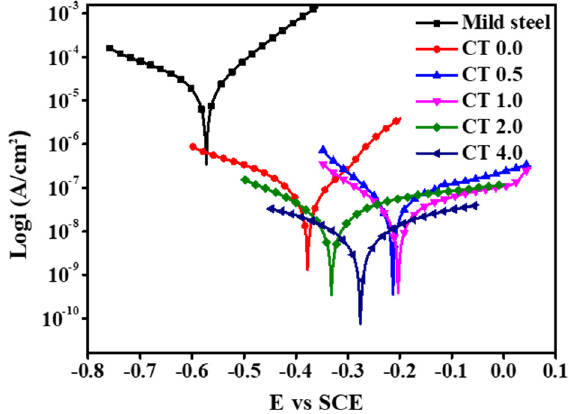
12 Figure 11. WCA of NIPU Composite Films . 3.3.7. Polarization Studies Tafel polarization measurement is a technique for analyzing the anti-corrosive prop- erties of polymeric coatings by evaluating the current vs. potential. By this technique, cor- rosion current (I corr ), corrosion potential (E corr ) and corrosion rate (C R ) on the metal panels were measured [36–38]. I corr and E corr will give bisecting extrapolated lines from both the oxidation and reduction parts. The Tafel study (Figure 12 and Table 5) of NIPU coated on the mild steel panel (3 × 3 cm 2 ) demonstrated that as loading of TANI increased, the rate of corrosion decreased. E Corr values of the coated NIPU panel shifted more towards posi- tive anodic values compared to that of the bare MS panel, which substantiates the superior control of the reaction (anodic and cathodic) because of barrier properties of NIPU coat- ings. CT 0.0 panel without TANI has showed a corrosion rate of 2.69 × 10 − 4 mm/year with a polarization resistance of 5.59 × 10 3 k Ω while NIPU with TANI loaded showed a lower corrosion rate with higher polarization resistance. With 4% loaded TANI, the C R was 1.67 × 10 − 5 mm/year with a high polarization resistance of 73.80 × 10 5 k Ω . This trend suggested that TANI reduced the corrosion rate of mild steel with its redox behavior [39].